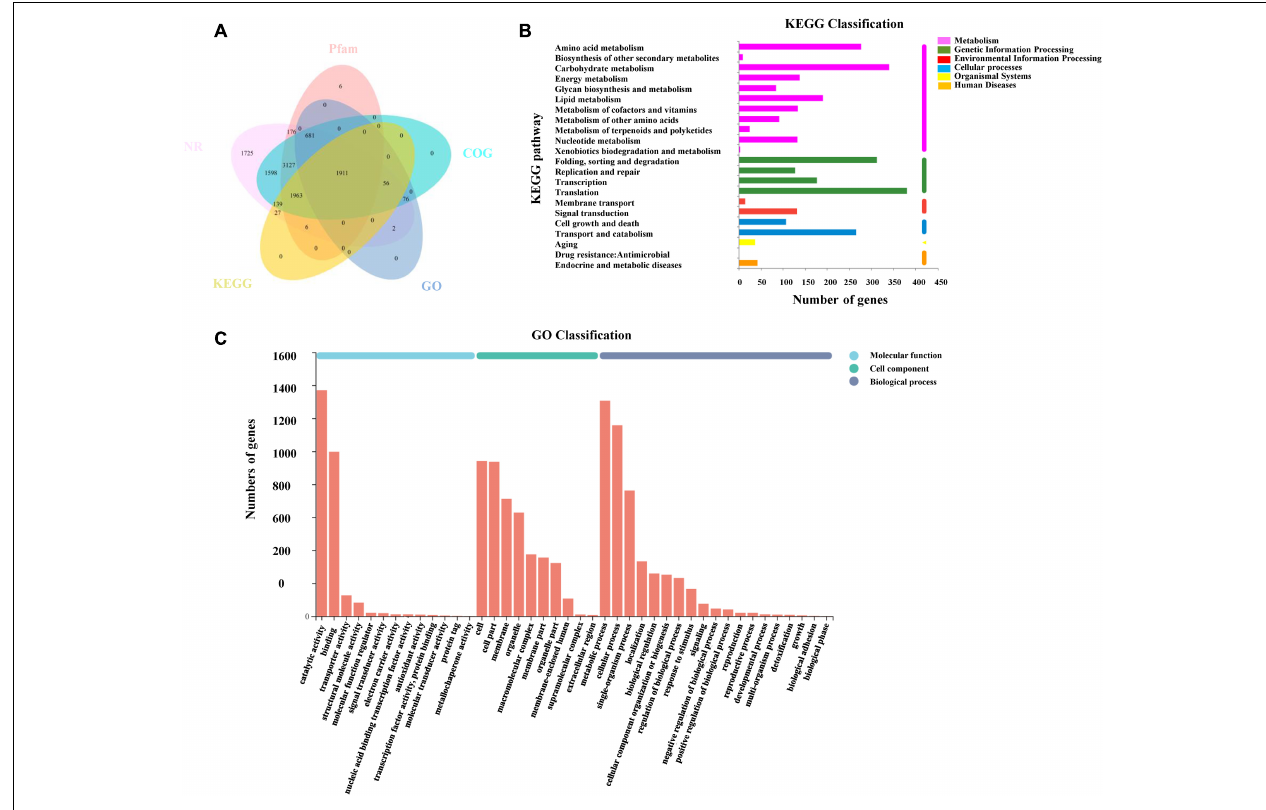
FIGURE 5 | Annotation information of assembled unigenes in L. edodes . (A) Venn diagram of the distribution of annotation information from five public databases. (B) KEGG classification of unigenes in L. edodes . (C) GO classification of unigenes in L. edodes